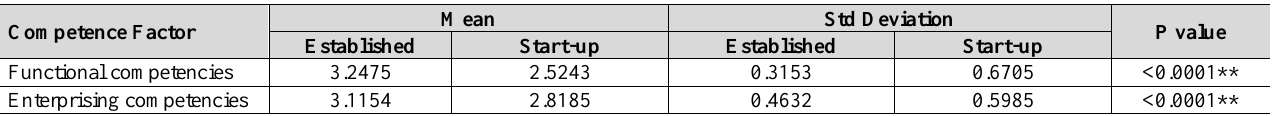
Table 6: Independent t-test - on proficiency of competencies